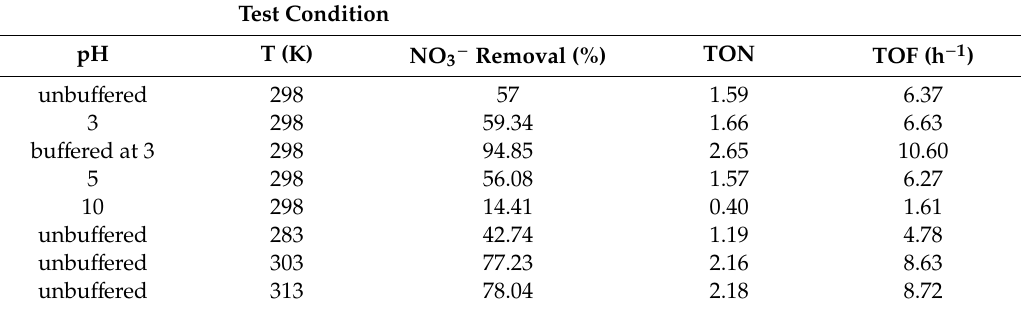
Table 1. Turnover number (TON) and turnover frequency (TOF) calculated at a catalyst dosage of 0.1 g/L.